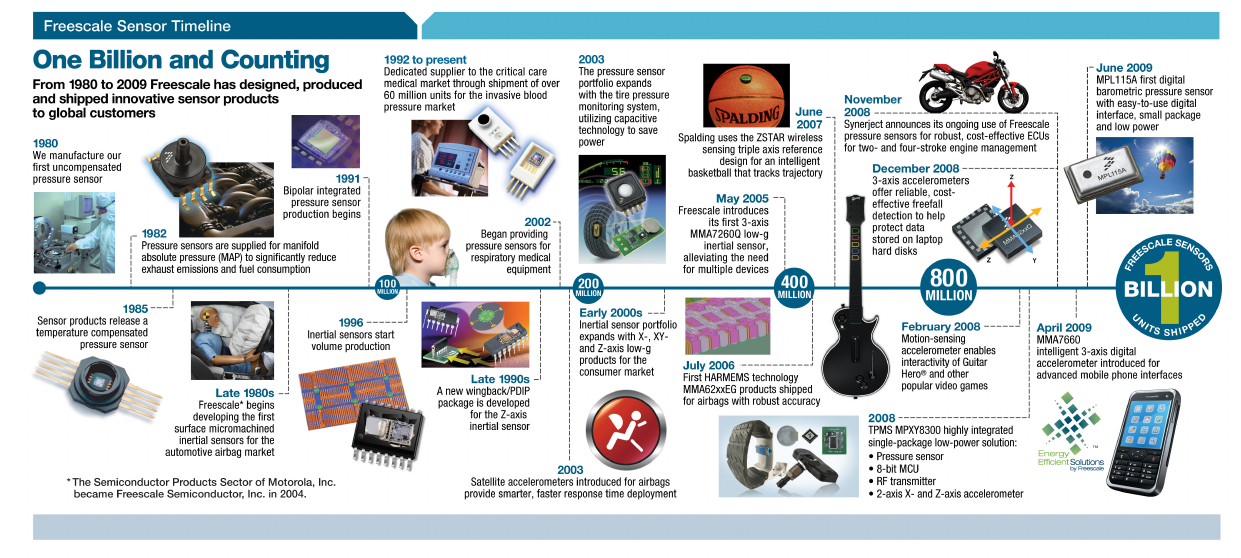
Figure 1. More than 30 years of Freescale